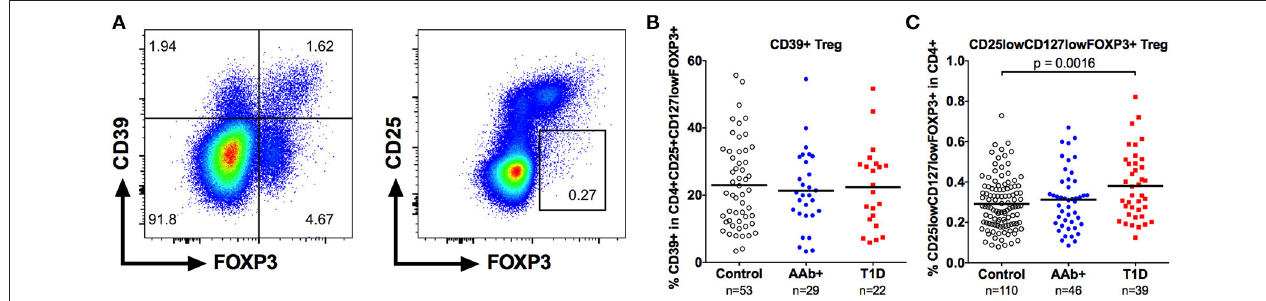
FIGURE 4 | Increased frequency of CD25lowCD127low Tregs but not of CD39 + Tregs in children with newly diagnosed T1D. A subset of CD4 + CD25 + CD127lowFOXP3 Tregs expresses CD39 ( A , left). A minor population of FOXP3 + cells is both CD25low and CD127low ( A , right). Frequencies of